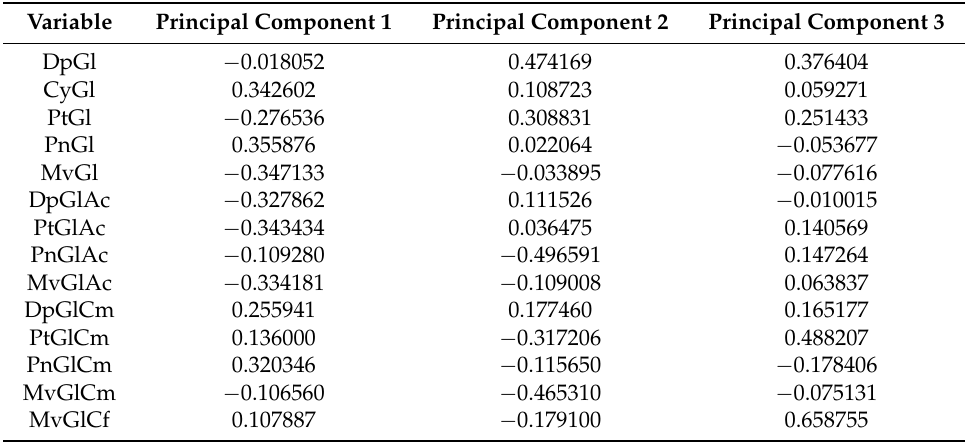
Table 8. Weight of the 14 variables determined by HPLC-DAD to obtain the anthocyanin fingerprint of Mencia and Alicante Bouschet wines in the principal components 1–3. For key to substances, see